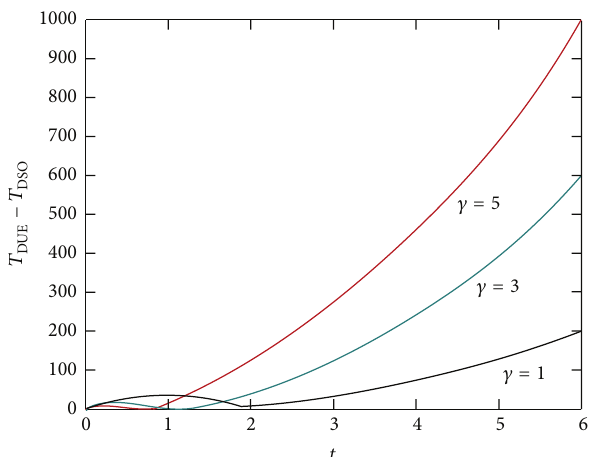
− 𝑇 with 𝑡 changing when the values of DUE DSO